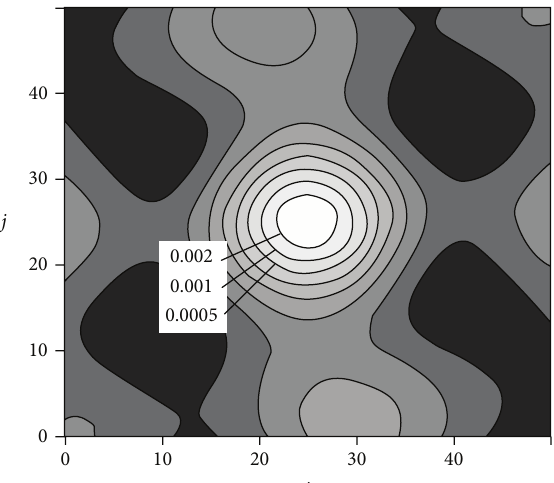
Figure 7: A map of levels in the two-dimensional correlation function of states 𝐺 1 (𝑖, 𝑗) corresponding to the 250th iteration in the absence of an external